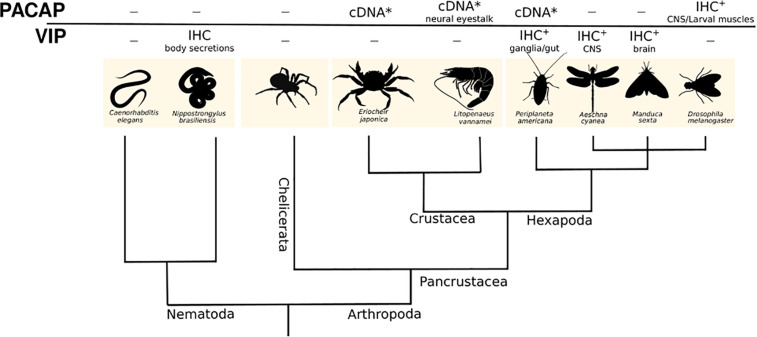
A dendrogram representing the phylogenetic relationships of the main Ecdysozoan phyla. Molecular and expression data (IHC) available for putative PACAP and VIP is presented (El-Salhy et al., 1983; Andries et al., 1984; Andriès et al., 1991). The tissues where putative PACAP or VIP were found are also indicated. - no data available; ∗ partial cDNA.